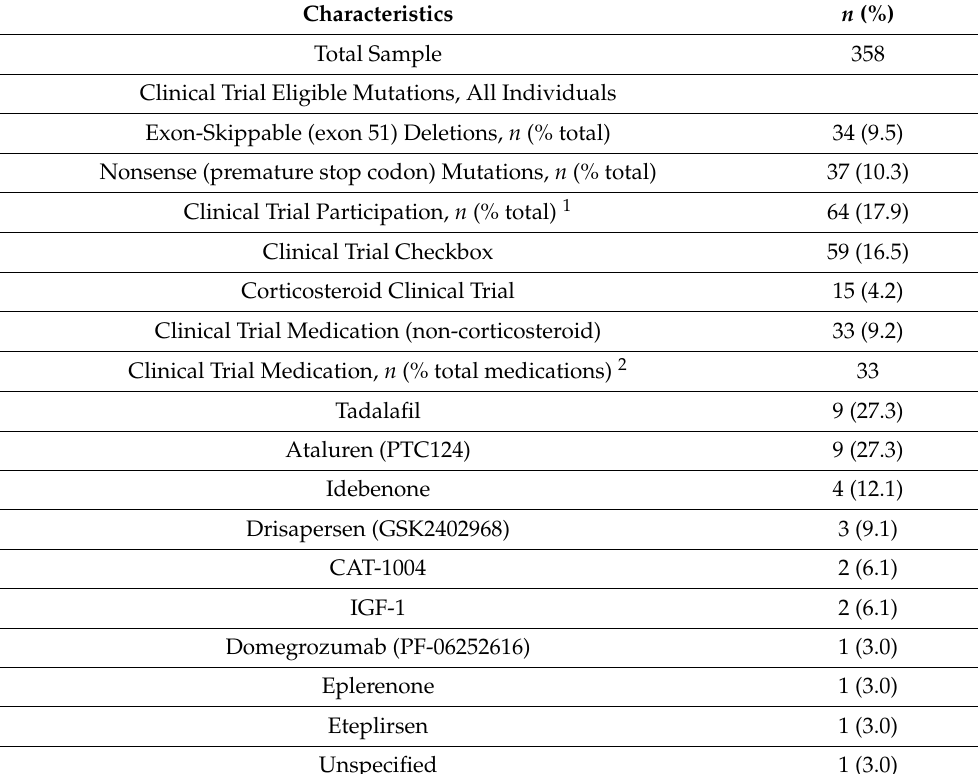
Table 1. Characteristics of Clinical Trial Eligibility and Participants in the Muscular Dystrophy Surveillance, Tracking, and Research Network (MD STAR net ), 2000–2015.